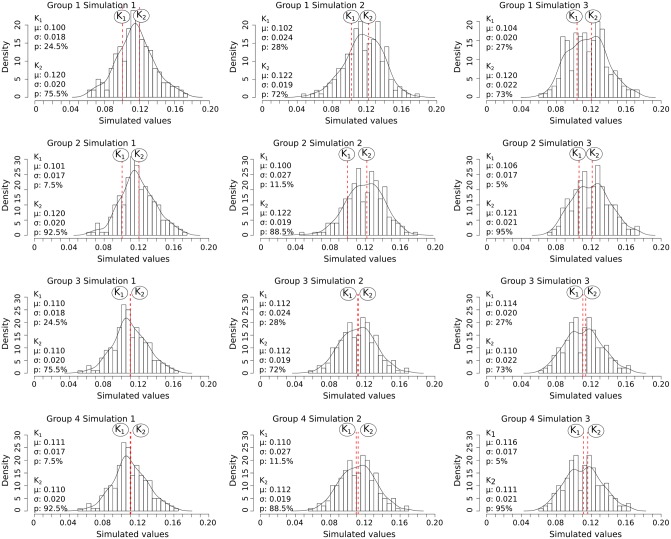
Density bar plots showing the distribution of simulated values for the two-component samples.Black curve: density curve for each sample; vertical red stapled lines: the position of the mean of each component (simulated morphotype) Kn. K1: component/morphotype 1. K2: component/morphotype 2. μ: the component mean. σ: the component standard deviation. p: the relative abundance.